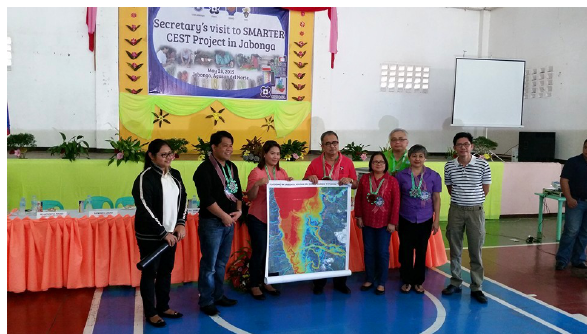
Figure 4: Flood hazard map turnover in the Jabonga